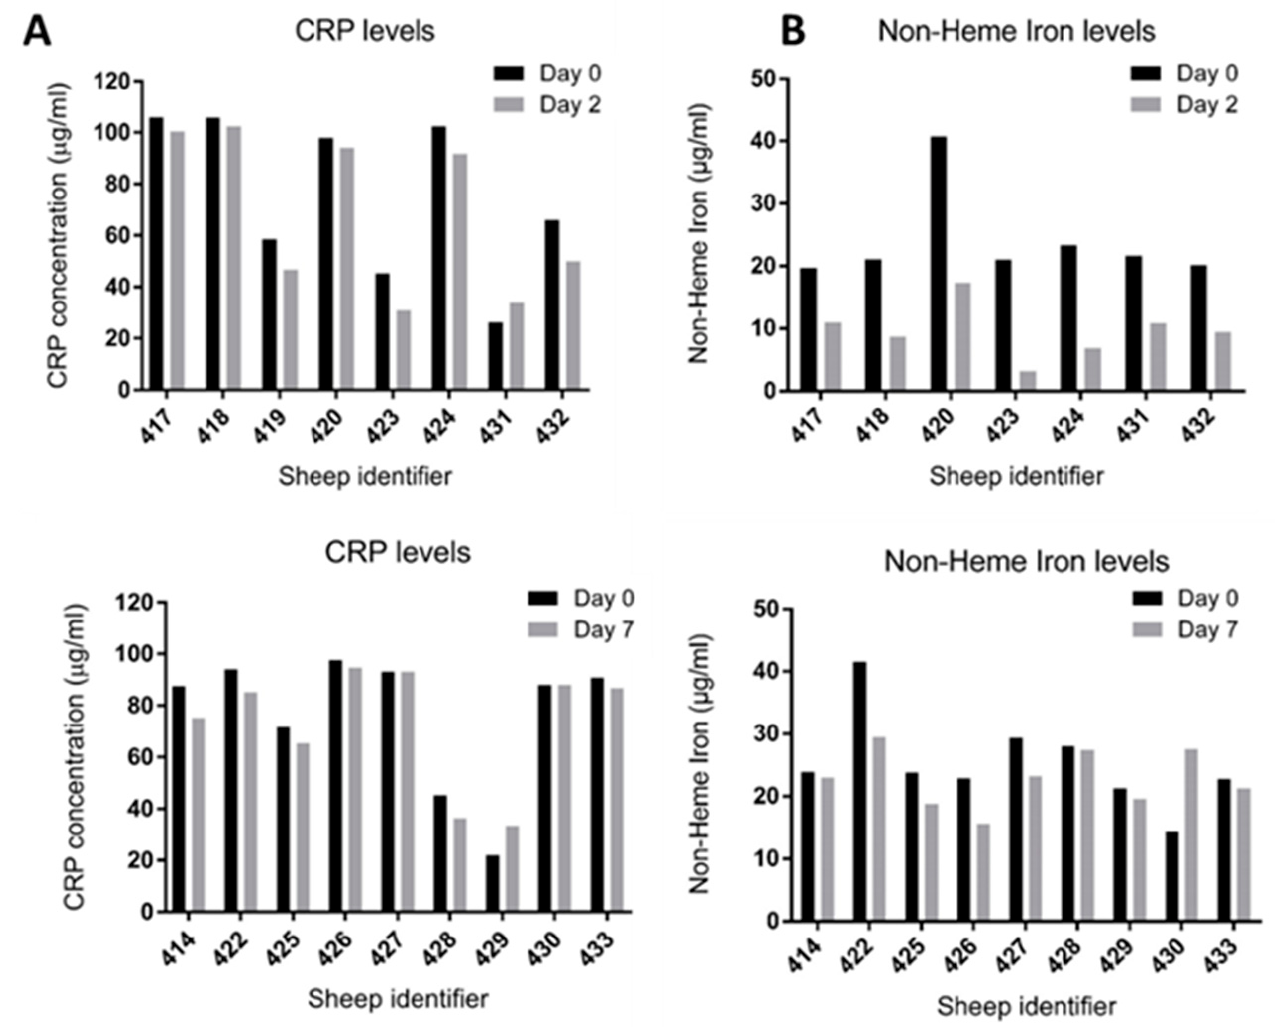
Figure 3. Quantification and comparison of ( A ) the CRP level and ( B ) the non-haem iron levels at day 0 (pre-implantation) and upon sacrifice at either day 2 or day 7. Data are expressed for individual sheep and presented by experimental sheep identifier numbers (414–433).